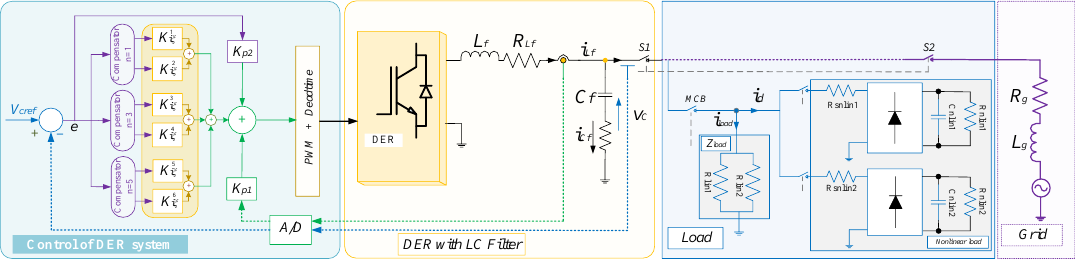
Figure 4. General scheme of the distributed energy resource (DER) system with the proposed